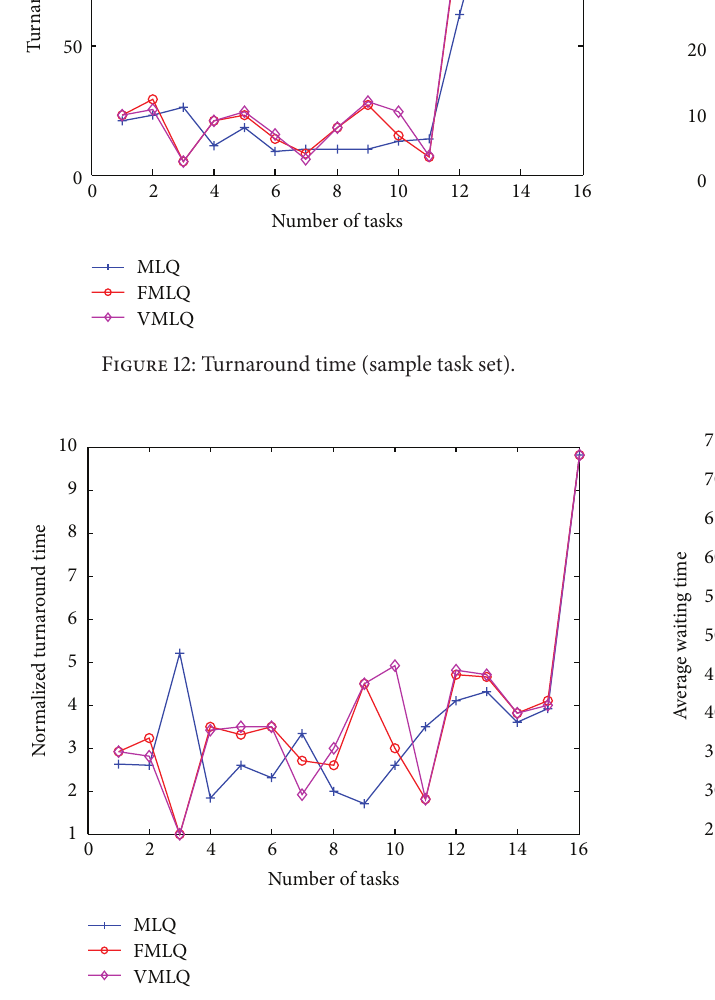
Figure 13: Normalized turnaround time (sample task set).